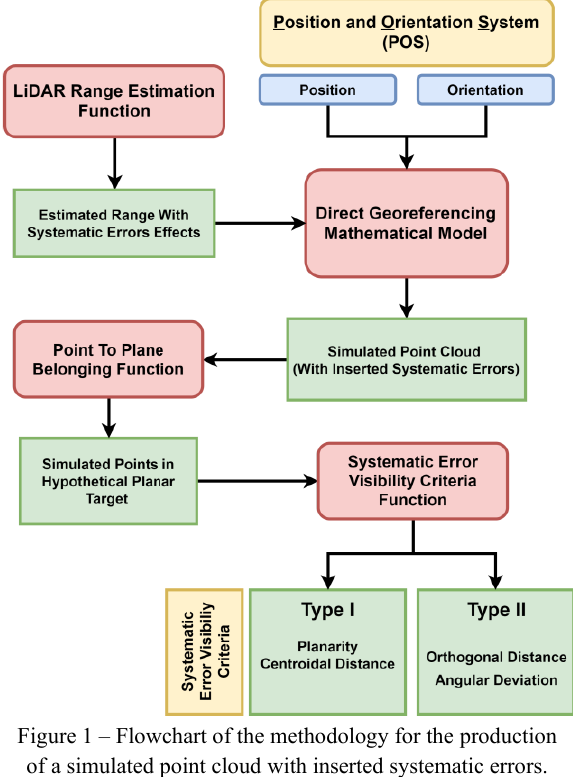
Figure 1 – Flowchart of the methodology for the production of a simulated point cloud with inserted systematic errors. Red boxes represent the functions. Green boxes are the results of the functions. The blue box is for